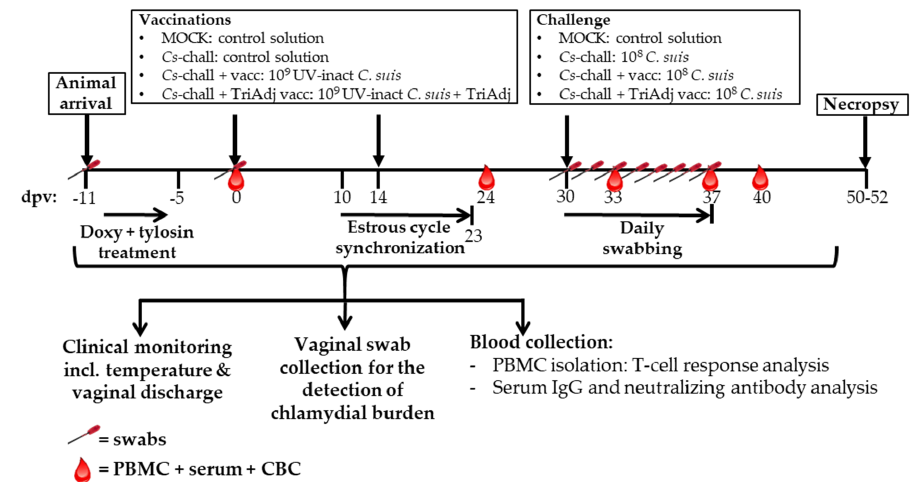
Figure 2. Setup of the in vivo C. suis vaccination experiment. Twenty-four sexually mature female C. suis pre-exposed pigs were randomly distributed into four groups with six pigs each. Pigs were treated with doxycycline and tylosin from 11 to 5 days post vaccination (dpv). At 0 and 14 dpv, pigs were vaccinated intranasally with: control solution (MOCK and Cs -chall), 10 9 UV-inactivated C. suis inclusion-forming units (IFU) ( Cs -chall + vacc), or 10 9 UV-inactivated C. suis IFU + Tri Adjuvant ( Cs -chall + TriAdj vacc). From 10–23 dpv, the estrus cycle of pigs was synchronized with synthetic progesterone. At 30 dpv, pigs were challenged trans-cervically with control solution (MOCK) or 10 8 C. suis IFU ( Cs -chall, Cs -chall + vacc and Cs -chall + TriAdj vacc). Pigs were clinically monitored every day throughout the study. Blood and vaginal swab collection were performed as indicated on the figure by the blood drop and the swab symbol. Necropsy was performed on 50–52 dpv. C. suis were